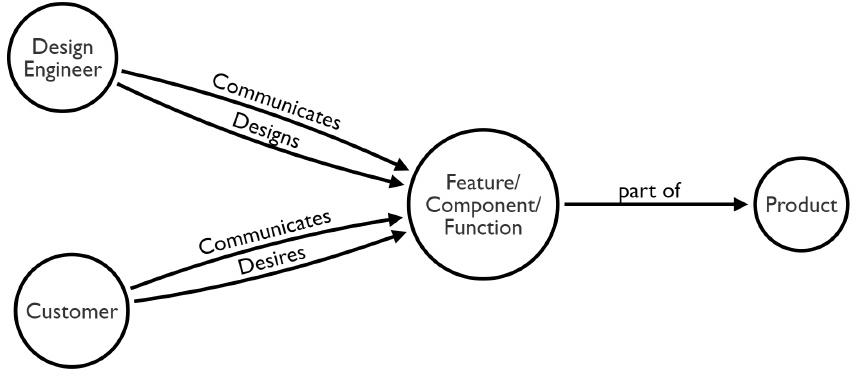
Figure 1. Interaction Model of designers, customers and